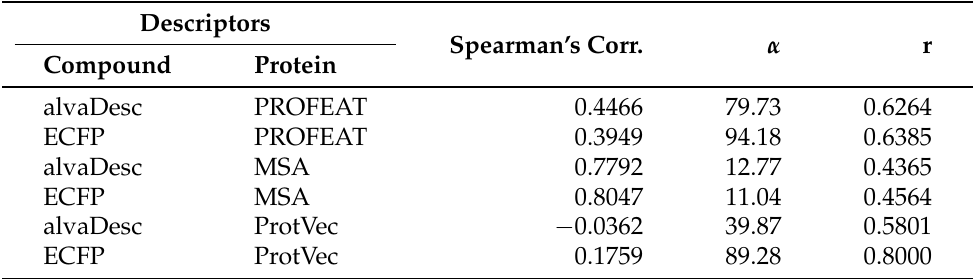
Table 4. Spearman’s correlation between AUROC and log A and the parameters α and r of the weight function for six combinations of compound and protein descriptors.